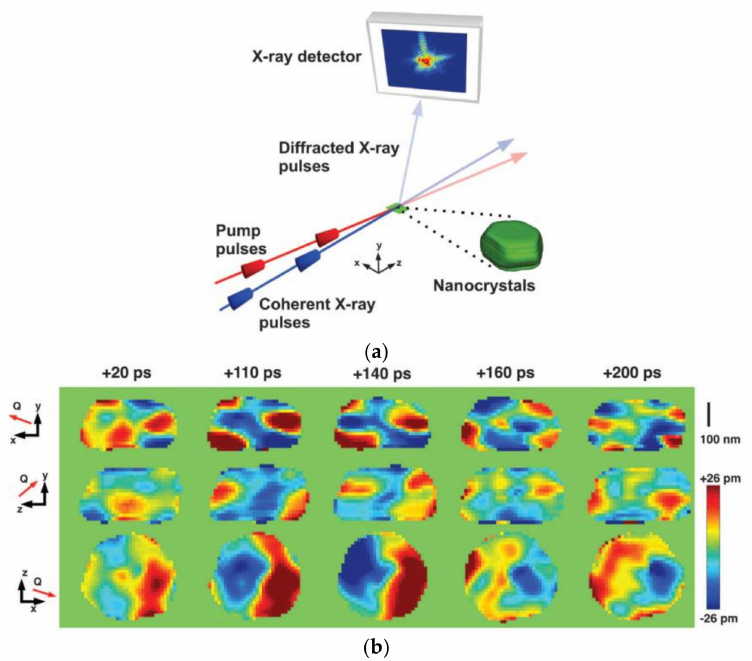
Figure 8. ( a ) Principle of ultrafast BCDI measurement. ( b ) Orthogonal section passing through the center of the particle, showing the composition of the displacement along the scattering vector Q as a function of time [95]. Reprinted from